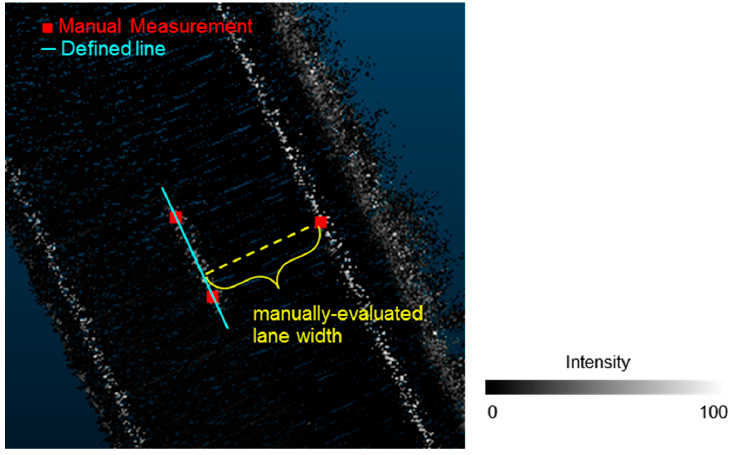
Figure 33. Road surface point cloud and points used for manual evaluation of lane width estimates.